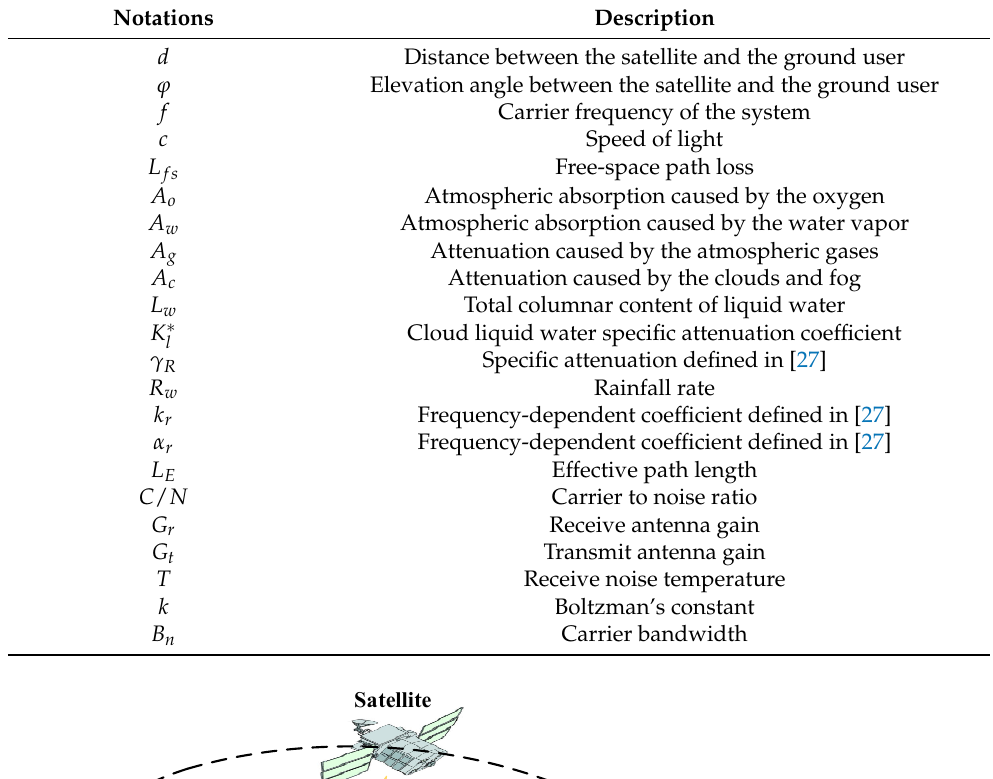
Table 1. Description of notations.